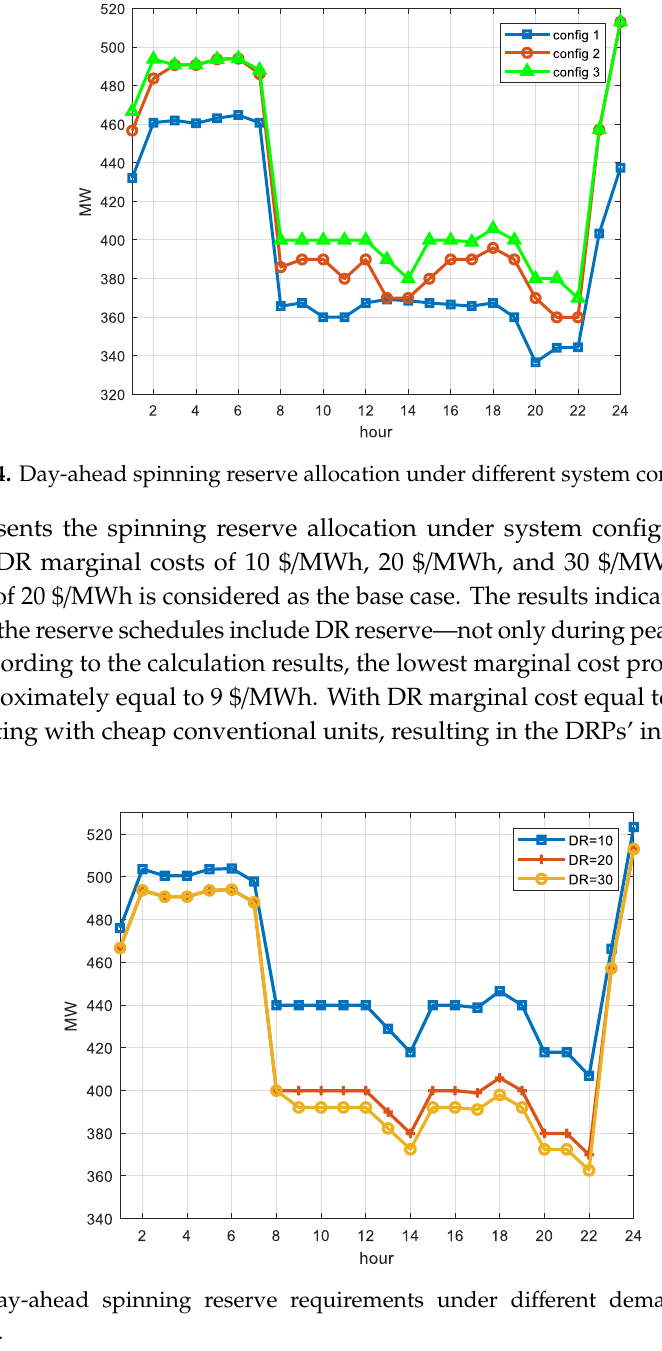
Figure 5. Day-ahead spinning reserve requirements under different demand response (DR) marginal costs.